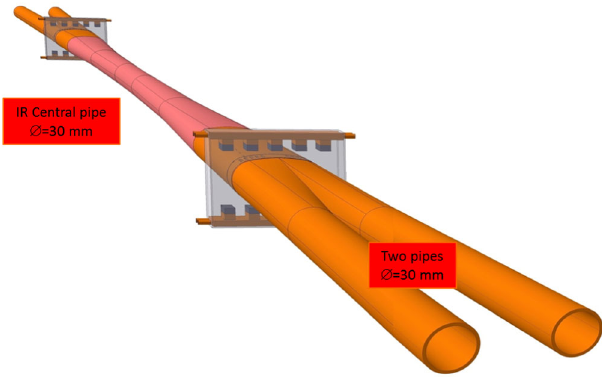
FIG. 15. IR smooth geometry with HOM